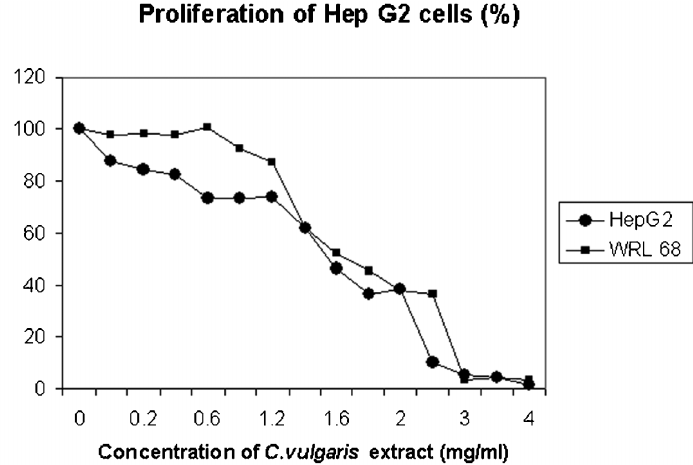
Figure 1 - The effect of Chlorella vulgaris extract on proliferation of HepG2 and WRL68 cell lines treated with different concentrations of C. vulgaris extract. Data are represented as mean ¡ SD. * Showed significant changes (p , 0.05) for n=3 triplicate after 24 hours of treatment with different concentrations of C. vulgaris extract using bromodeoxyurdine (BrdU) assay with 50% reduction (IC 50 ) seen at 1.6 mg/ml for HepG2 cells and 1.7 mg/ml for WRL68